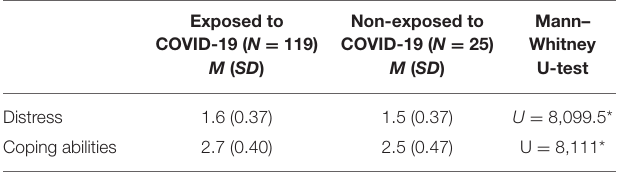
TABLE 1 | Mean scores, standard deviations, and results of the non-parametric t -tests. Exposed to Non-exposed to COVID-19 ( N = 119) COVID-19 ( N = M ( SD )